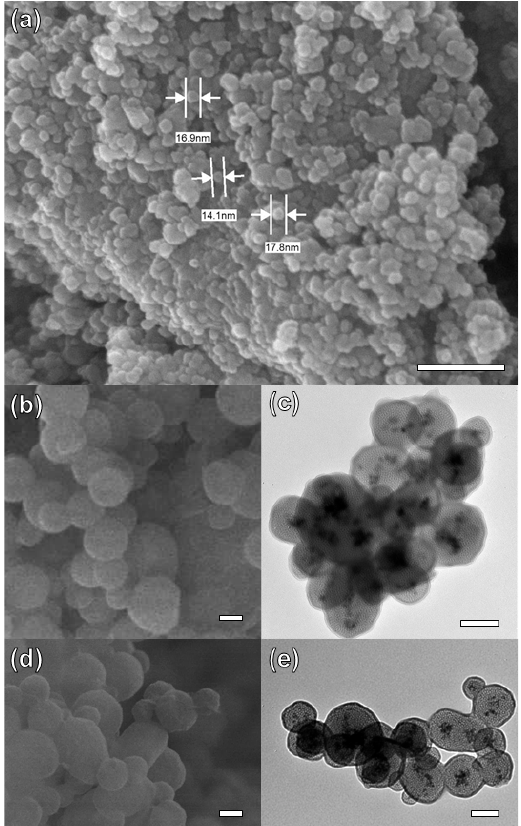
Figure 1. ( a ) SEM Fe 3 O 4 ( b ) SEM Fe 3 O 4 coated with Si ( c ) TEM Fe 3 O 4 coated with Si ( d ) SEM Fe 3 O 4 coated with Si and polymer ( e ) TEM Fe 3 O 4 coated with Si and polymer. Scale bar 100 nm for all images ( a – e